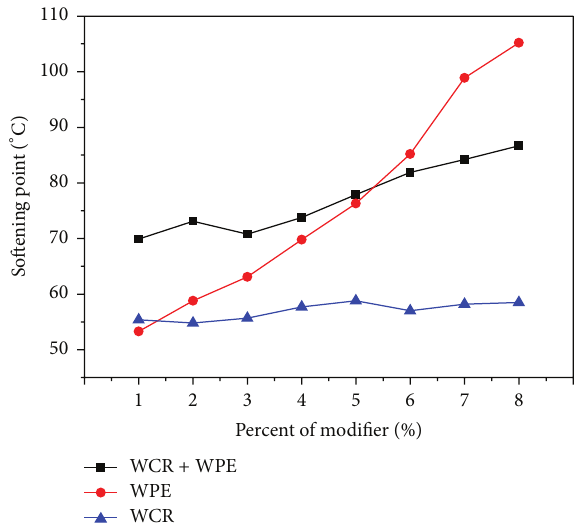
Figure 3: The penetration of modified asphalt at 25 ∘